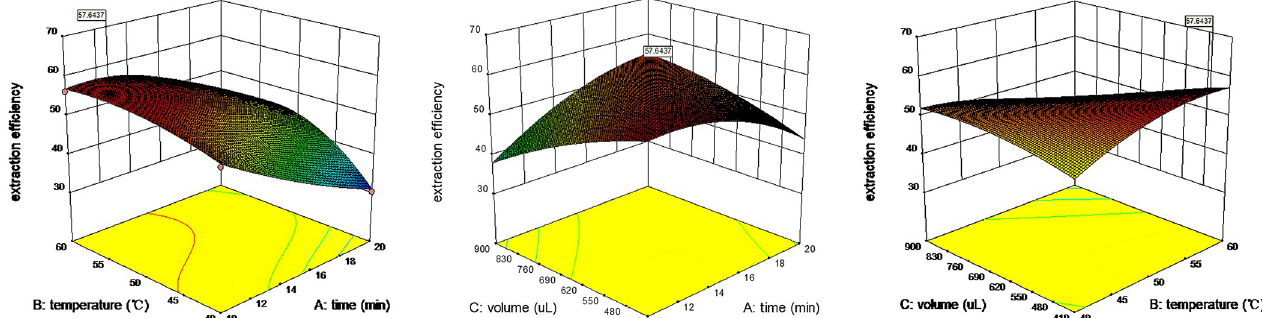
Fig 3. Response using CCD obtained by plotting: (a) time vs. temperature; (b) time vs. volume; (c) temperature vs. volume.